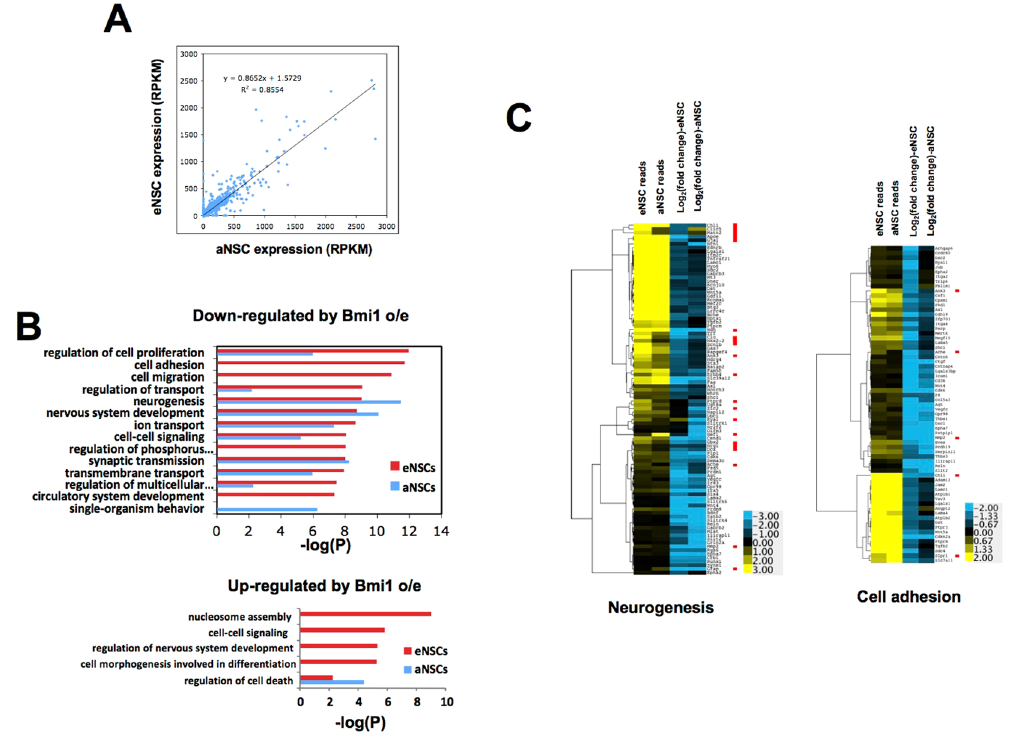
Figure 4. Effect on gene expression of Bmi1 overexpression in eNSCs compared to aNSCs. ( A ) Comparison of transcript levels measured by RNA-seq (reads per kilobase per million reads mapped, RPKM) in embryonic and adult NSCs (empty vector control, average of two biological replicates). ( B ) Gene ontology categories enriched for genes down-regulated (top) or up-regulated (bottom) upon Bmi1 overexpression in eNSCs (red bars) or aNSCs (blue bars). Categories having P < 10 − 6 (hypergeometric test, corrected for multiple category testing) are shown for down-regulated genes and having P < 10 − 4 for up-regulated genes; GO categories having more than 1624 member genes (the number in nervous system development) are not shown. ( C ) Hierarchical clustering was performed for genes down-regulated at least two-fold by Bmi1 overexpression with p < 0.01 in either eNSCs or aNSCs and belonging to the GO category Neurogenesis (left) or by at least two-fold in eNSCs with p < 0.01 and belonging to Cell Adhesion (right). The right-hand two lanes in each panel depict as heat maps log 2 of the change in expression between cells overexpressing Bmi1 and control cells, while the left-hand lanes indicate relative expression levels in control cells (transduced with empty vector). Reads (RPKM) were divided by 6 prior to clustering to allow them to be visualized on the same scale as the log 2 changes in expression. Red dots mark genes expressed at a level of at least 3 RPKM (before correction) and differing at least two-fold in expression level between eNSCs and aNSCs. Note that the color scales are different for the two clustering